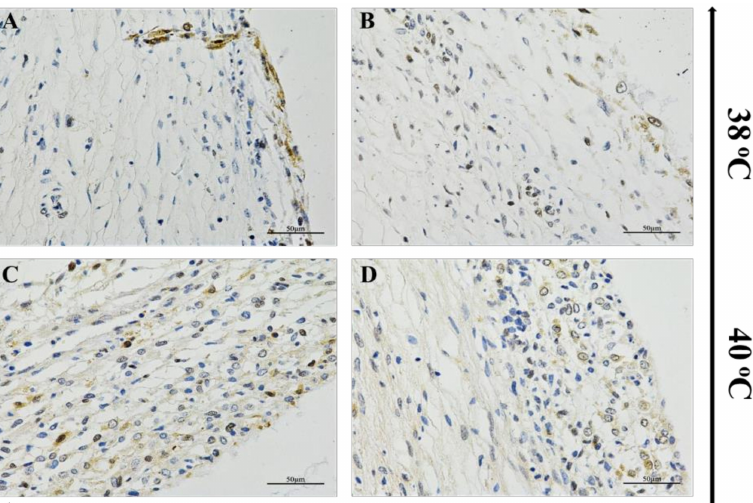
Figure 1. Detection of CAT expression in ovarian follicle. The appearance of bluish granules scattered within the follicular wall indicated an increased positive staining for the CAT protein in the heat-treated group (40 ◦ C) ( C , D ) than the control ( A , B ), examined by immunohistochemistry. The stained sections were developed with DAB substrates and visualized under a light contrast